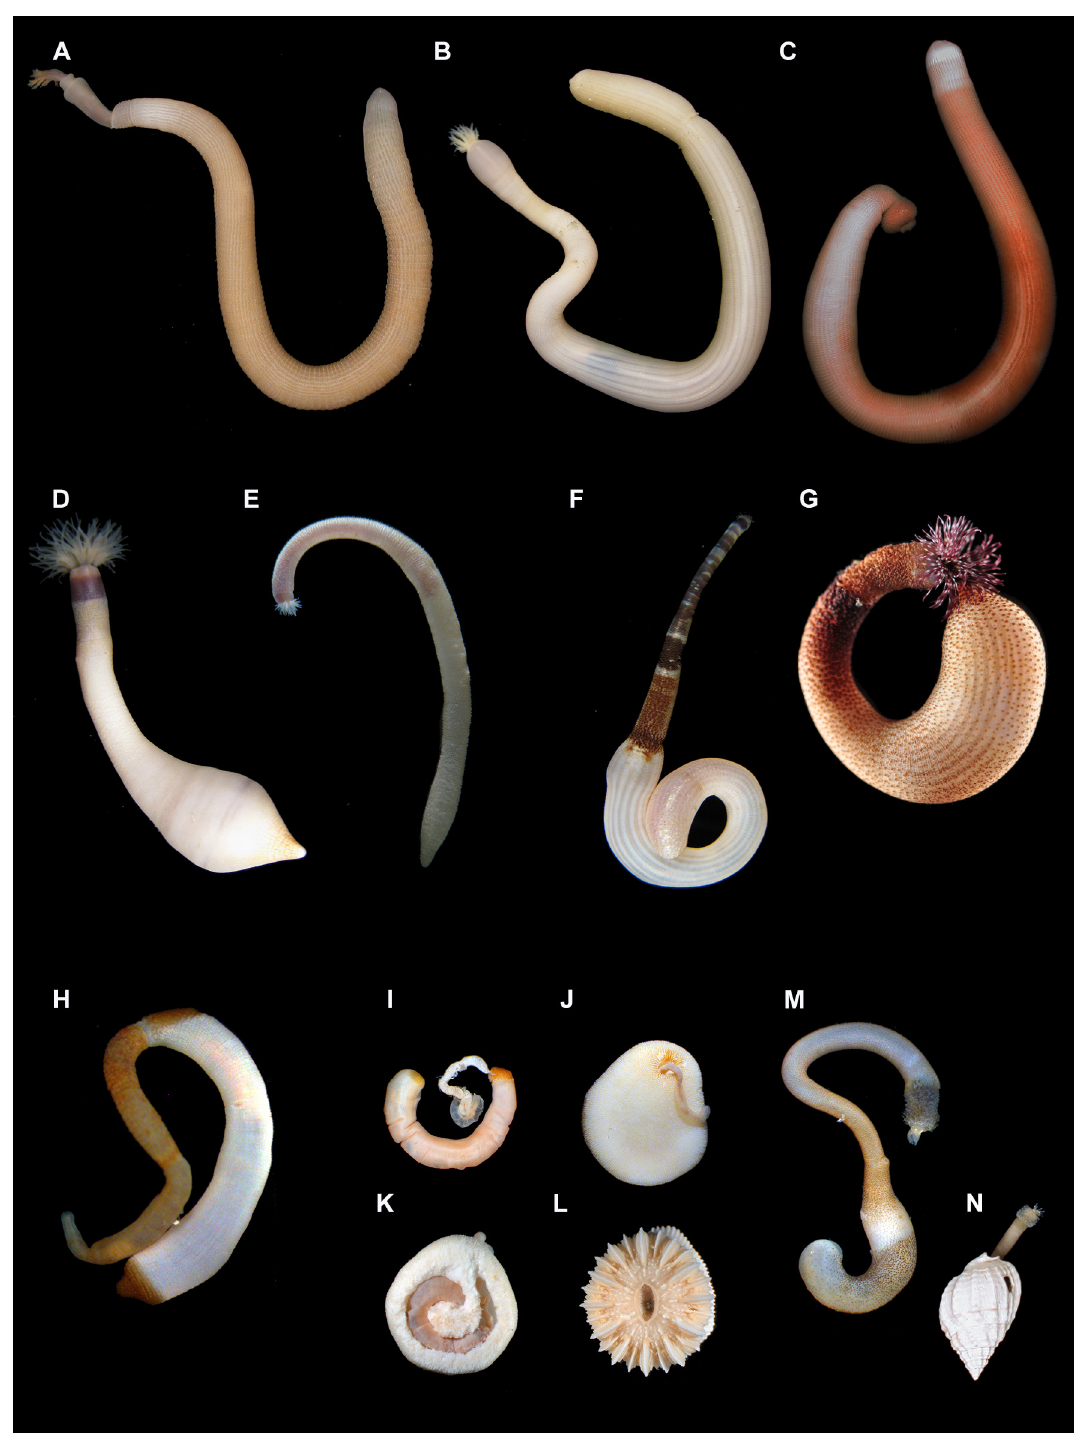
Figure 2. Diversity of sipunculan body plans ( A ) Sipunculus phalloides ; ( B ) Siphonosoma cumanense ; ( C ) Xenosiphon branchiatus ; ( D ) Themiste langeniformis ; ( E ) Nephasoma pellucidum ; ( F ) Phascolosoma perlucens ; ( G ) Antillesoma antillarum ; ( H ) Aspidosiphon fischeri ; ( I ) Aspidosiphon muelleri , a commensal sipunculan living in symbiosis with a solitary coral; ( J ) A. mulleri introvert coming out from a whole in the base of the coral made by the worm; ( K ) space inside a solitary coral inhabited by A. mulleri ; ( L ) solitary coral from the genus Heteropsammia ; ( M ) Phascolion cryptum ; ( N ) P. cryptum inside a gastropod